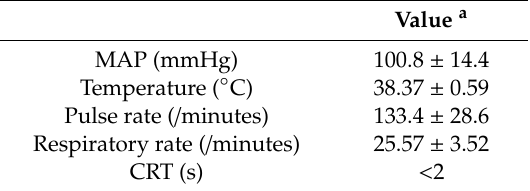
Table 1. Physical examination measured at the time of blood sampling.